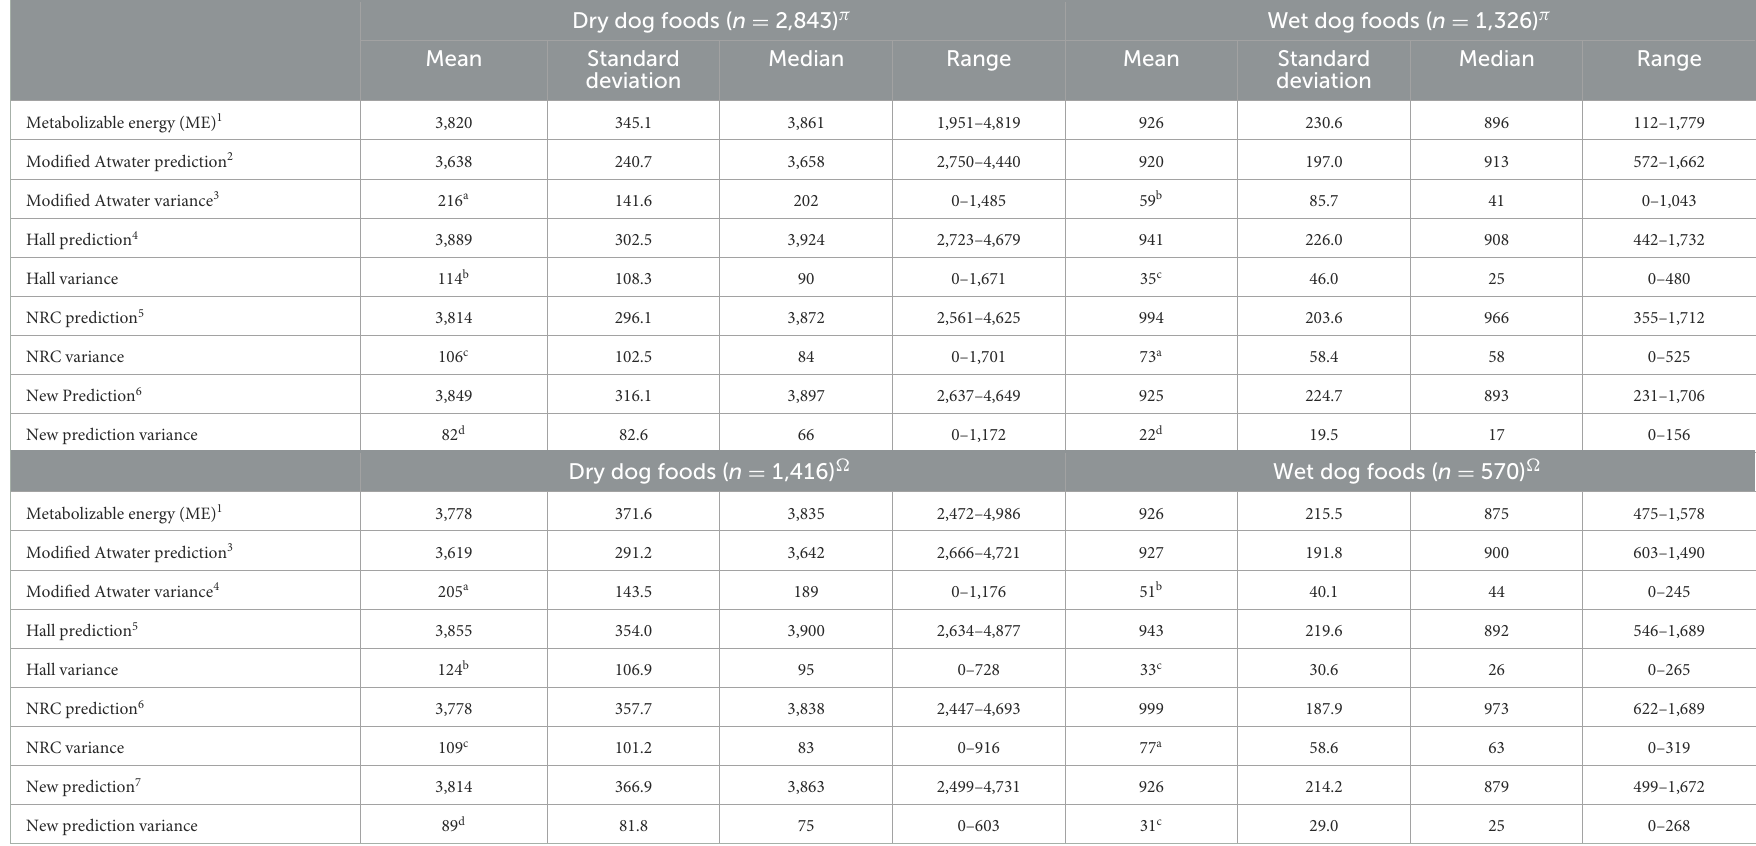
TABLE 5 Canine tested and estimated metabolizable energy